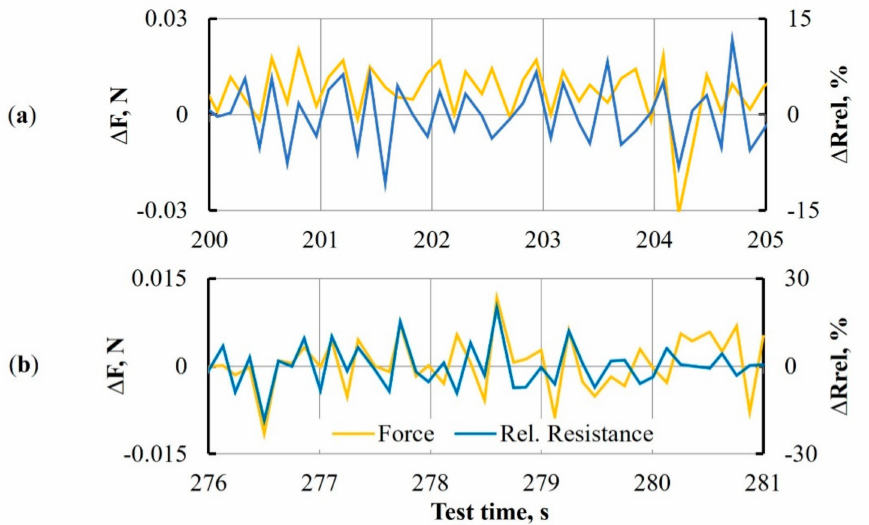
Figure 21. Parameters ∆ F and ∆ R rel . in time intervals of 200–205 ( a ) and 276–281 s ( b ) during crack propagation for neat epoxy-based DCB specimen with MWCNT spray-coated interleave.